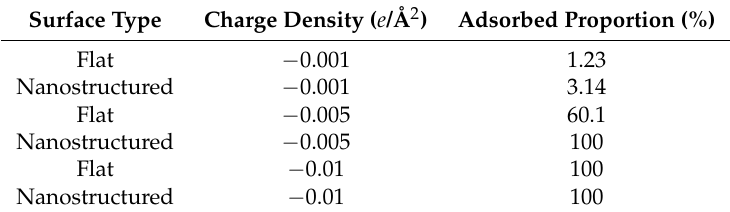
Table 4. The proportions of the fibrinogen α C-chain that are adsorbed in simulations with flat and nanostructured